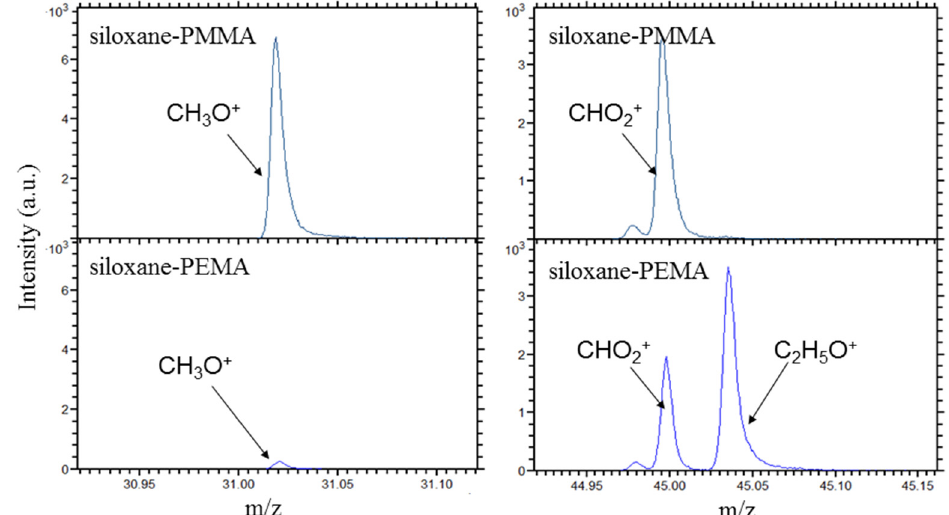
Figure 5. ToF-SIMS spectra of positive secondary ions at mass to charge ratios ( m / z ) around 31 and 45 with indicated methoxy CH 3 O + and ethoxy C 2 H 5 O + fragments. Spectra were recorded for siloxane-PMMA and siloxane-PEMA hybrid sol-gel coatings.